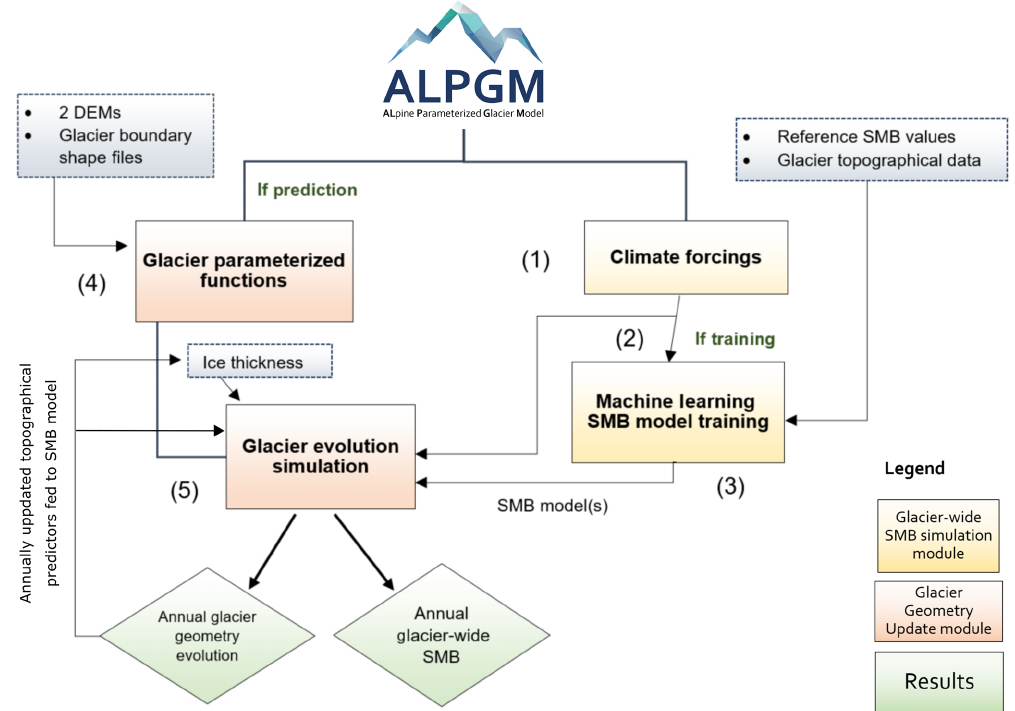
Figure 1. ALPGM structure and